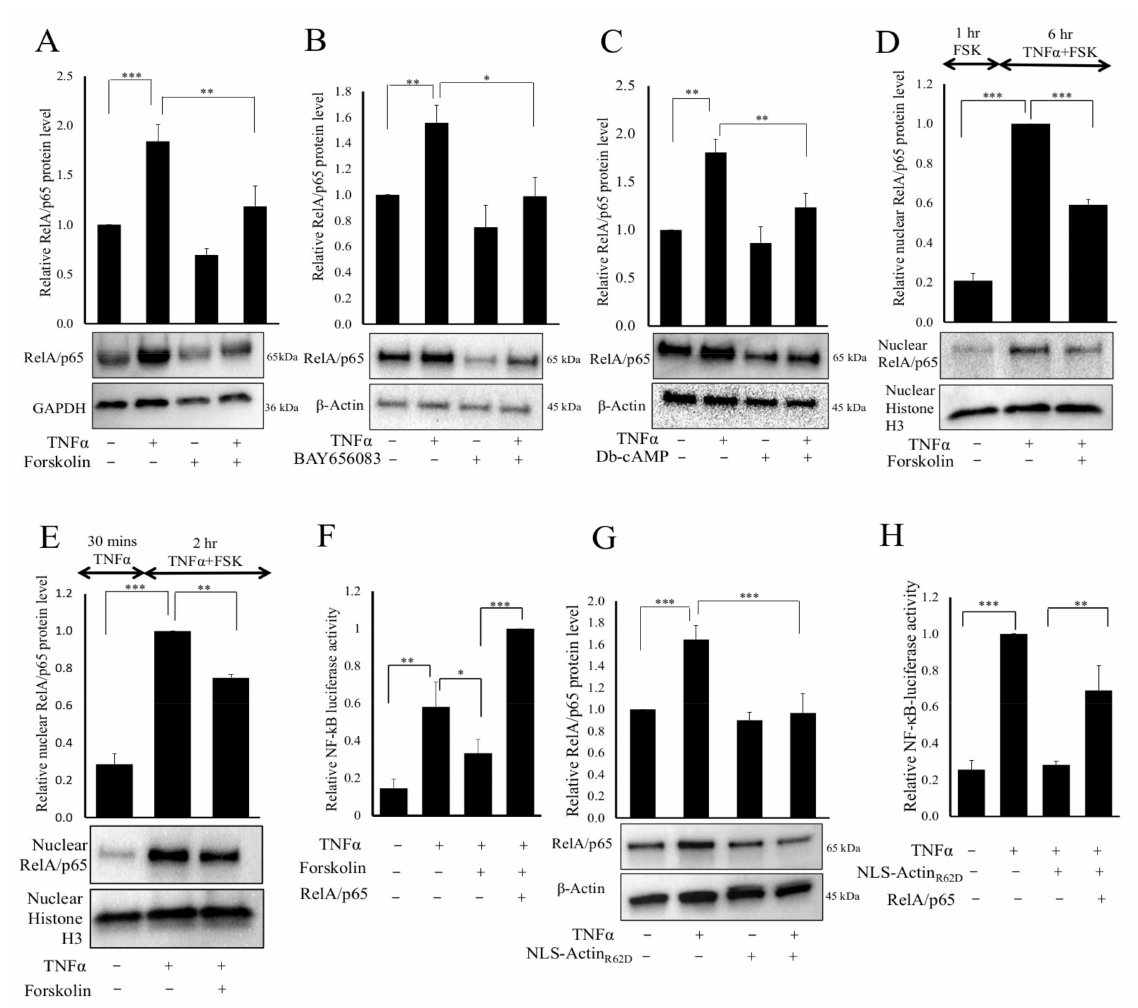
Figure 6. Cyclic-AMP-signalling reduces RelA/p65 protein levels. Serum starved VSMCs were stimulated with 25 µ M forskolin (( A ); n = 6), 5 µ g/mL BAY60-6583 (( B ); n = 6), or 200 µ M Db- cAMP ( C ; n = 6) for 1 h before TNF α stimulation for a further 6 h. Total cell lysates were analysed for RelA/p65 and β -actin protein levels by Western blotting and densitometry analysis. Nuclear fractions were prepared and analysed for RelA/p65 protein levels (( D ); n = 4). Cells were pre-treated with TNF α for 30 min prior to stimulation with forskolin for 2 h and nuclear fractions analysed for RelA/p65 levels (( E ); n = 3). VSMCs were transfected with NF- κ B-LUC and either a control expression plasmid or a plasmid overexpressing RelA/p65, as indicated. Serum-starved cells were treated with forskolin for 1 h before TNF α stimulation for 6 h. NF- κ B reporter activity was quantified (( F ); n = 4). Cells were infected with either Ad:Control or Ad:NLS-Actin R62D and stimulated with TNF α for 6 h the following day. Total cell lysates were analysed for RelA/p65 and GAPDH protein levels by Western blotting and densitometry analysis (( G ); n = 8). Cells were transfected with the NF- κ B reporter and either a control or RelA/p65 expression plasmid and infected with either Ad:Control or Ad:NLS-Actin R62D as indicated. Cells underwent 6 h stimulation with TNF α before NF- κ B activity was measured (( H ); n = 4). ANOVA with Student Newman Keul’s post hoc test. Data are mean ± SEM. *, ** and *** indicate p < 0.05, 0.01 and 0.001,